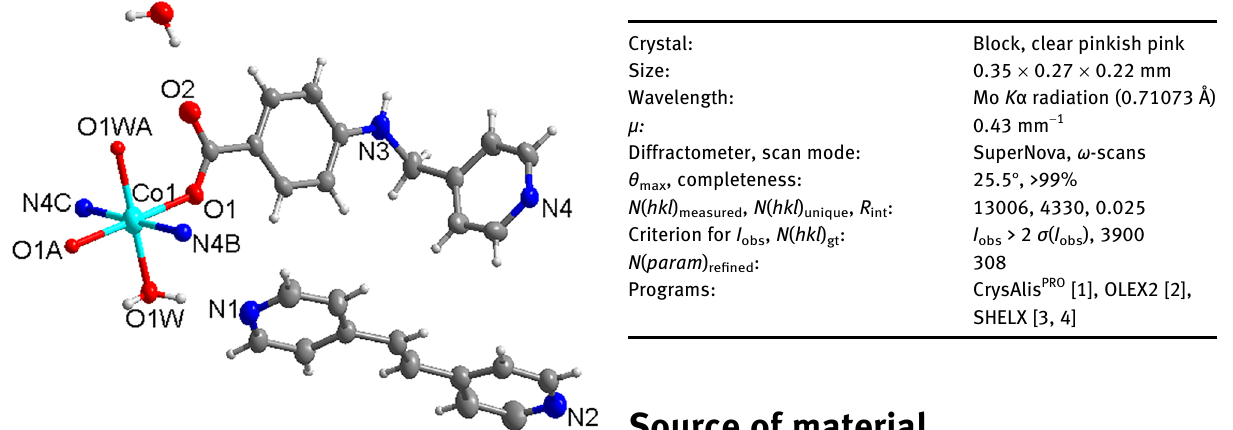
Table 1 contains crystallographic data and Table 2 contains the list of the atoms including atomic coordinates and displacement parameters.